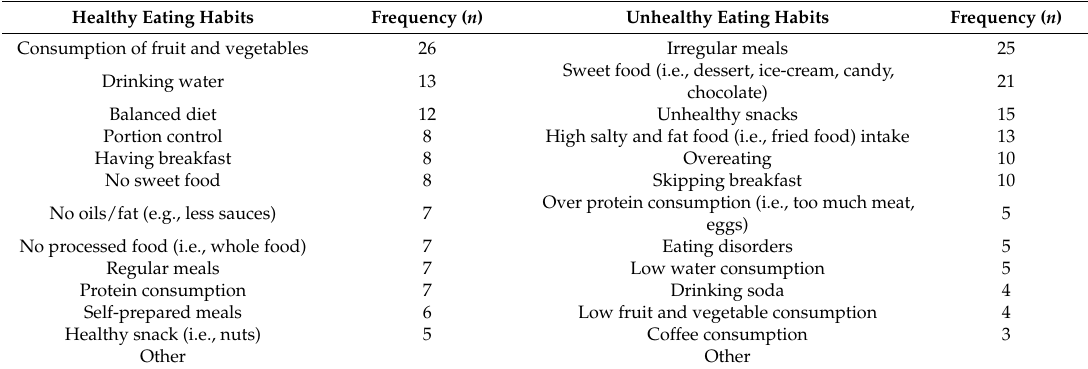
Table 3. Top 12 self-reported healthy and unhealthy eating habits of the